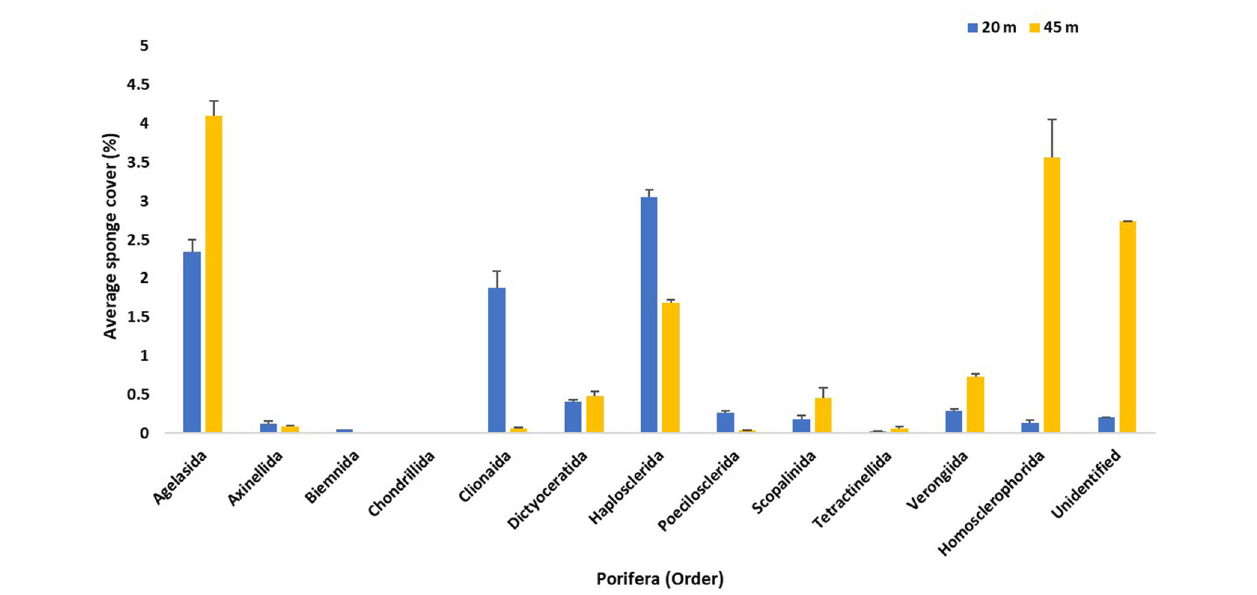
FIGURE 8 | Average percent cover ( + SE) per sponge Orders from both the altiphotic and deep transect surveys along the central portion of the Guánica shelf edge. A total of 40 m 2 were surveyed per depth stratification and percent cover was calculated in CPCe and tabulated using custom Linux scripts.